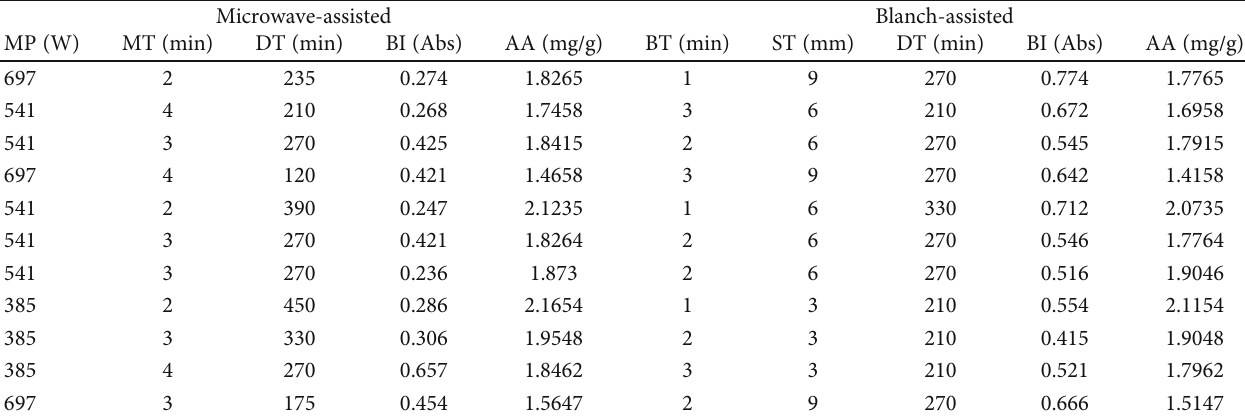
Table 5: Two-factor three-level factorial RSM design and results of BI, DT, and AA for microwave and blanch-assisted drying of orange- fl eshed sweet potato.